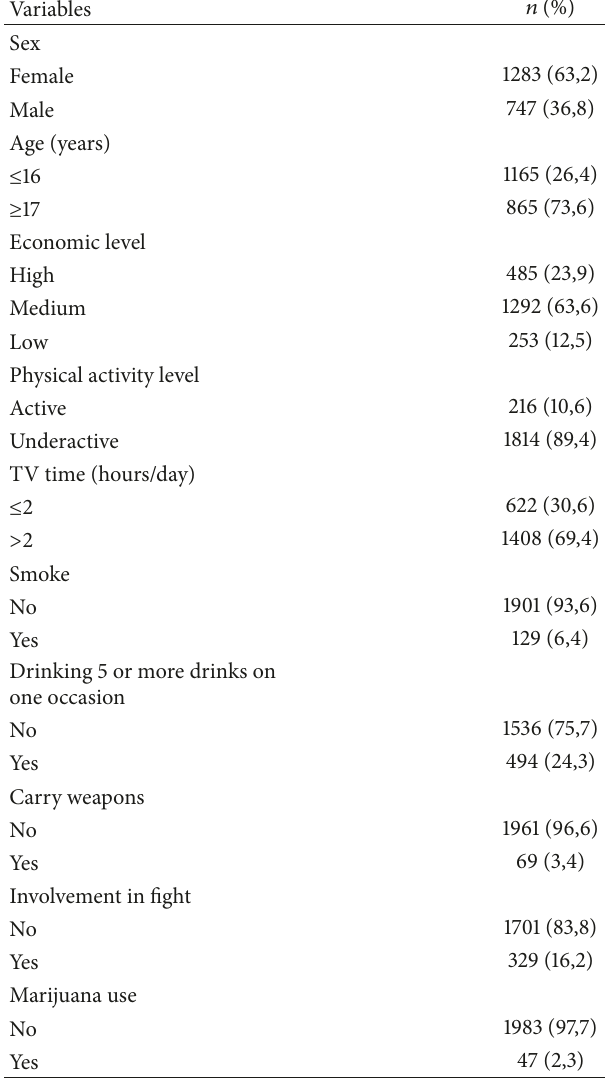
Table 2: Distribution of the sample according to sex, the age, the economic level, and behaviors of risk to health. Geoeconomic region “Grande Aracaju,”